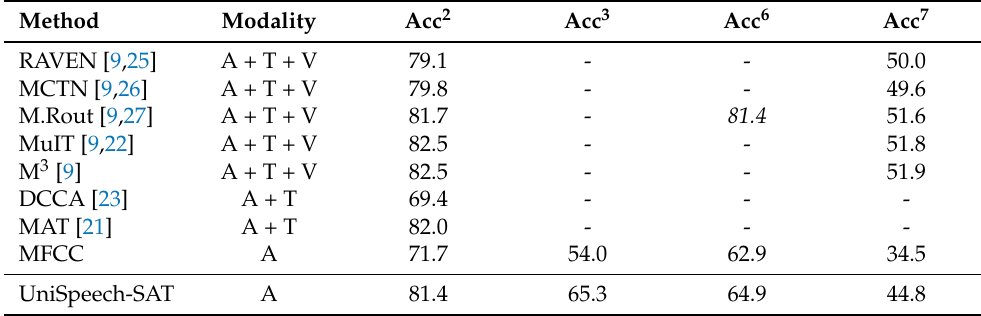
Table 4. Comparison of accuracies (WA%) of the results of previous studies using the CMU-MOSEI dataset; A: audio, T: text, V: video; scores in italics denote